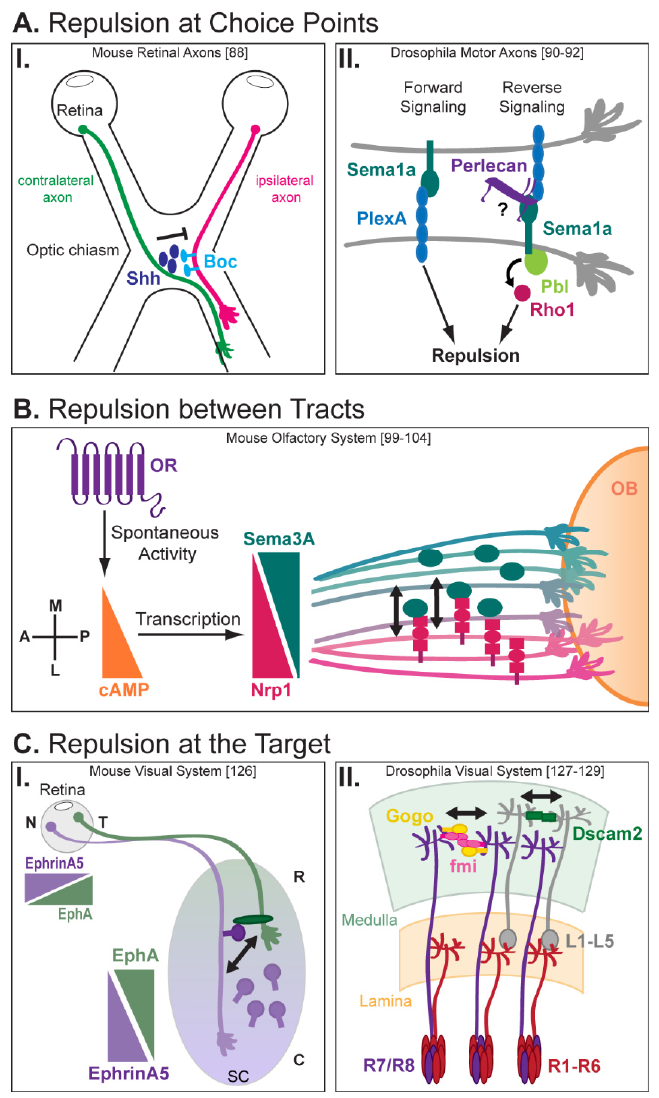
Figure 2. Axon–axon interactions regulate axonal repulsion during neural circuit wiring. ( AI ) In the mouse visual system, contralateral retinal axons arriving early at the optic chiasm secrete Sonic Hedgehog (Shh), which repels later-arriving ipsilateral axons that express the Shh receptor Boc [88]. ( AII ) Both forward and reverse Sema1a signaling regulate motor axon repulsion in Drosophila. Reverse signaling relies on the activation of Rho1 by Pebble (Pbl), and possibly secreted Perlecan [90–92]. ( B ) In the mouse, axon–axon repulsion establishes pre-target axon sorting of olfactory sensory axons. ORs produce patterns of spontaneous activity that generate different levels of cyclic adenosine monophosphate (cAMP). cAMP then activates transcription of Nrp1, which is expressed in a complementary manner to its ligand, Sema3A, in the olfactory nerve. Repulsive signaling between Nrp1- and Sema3A-expressing axons sorts axons as they extend to the olfactory bulb (OB) [99–104]. ( CI ) Repulsion between nasal and rostral retinal axons at the superior colliculus (SC) contributes to topographic mapping. EphrinA5 is highly expressed by nasal retinal axons while EphA is high on temporal retinal axons. Temporal axons are repelled from the caudal SC by EphrinA5 present in both the environment and at the surface of nasal axons [126]. ( CII ) In the Drosophila visual system, Dscam2 interactions mediate repulsion and proper spacing of L1-L5 axon arbors in the medulla. Spacing of R7 / R8 axon arbors is mediated by Flamingo (Fmi) and Golden goal (Gogo) interactions